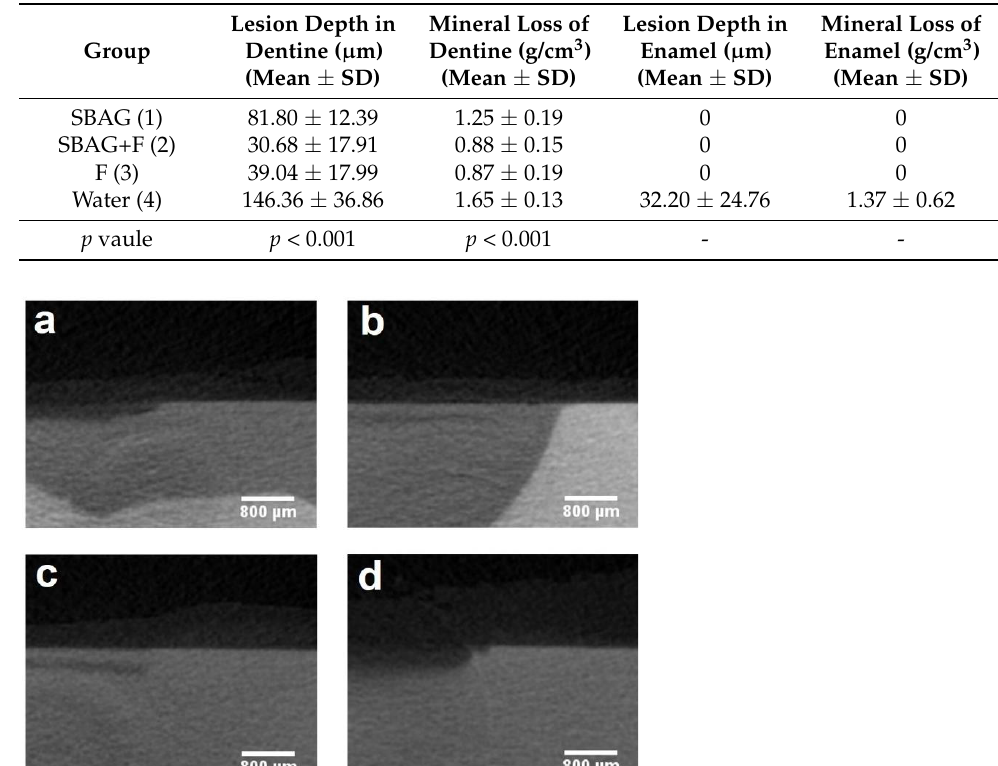
Table 1. The mean lesion depths and mineral loss of dentine and enamel after pH-cycling.